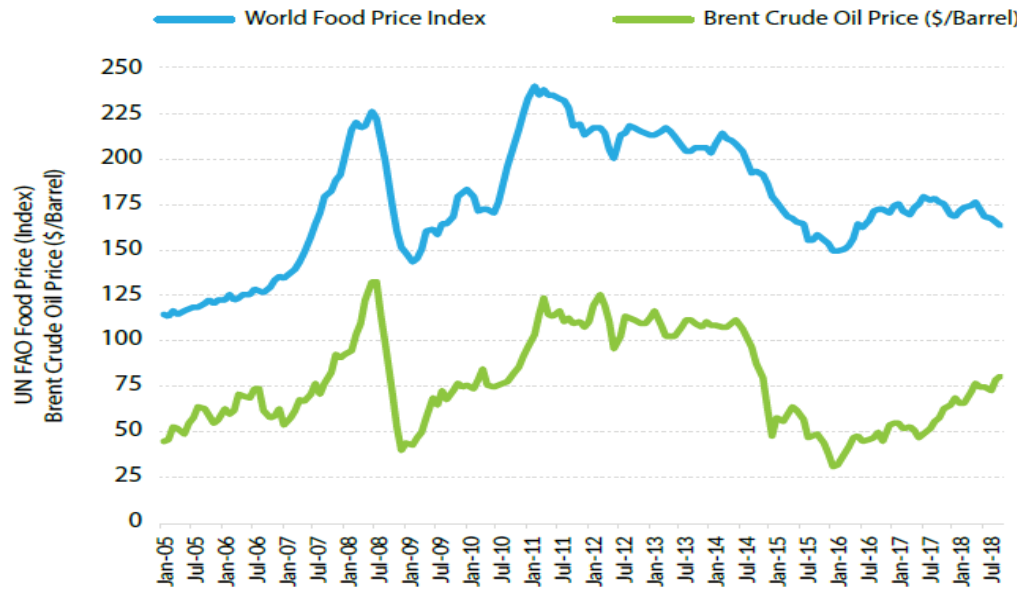
Figure 4. Connection between the world food price index and the BRENT crude oil price. Source: [11].